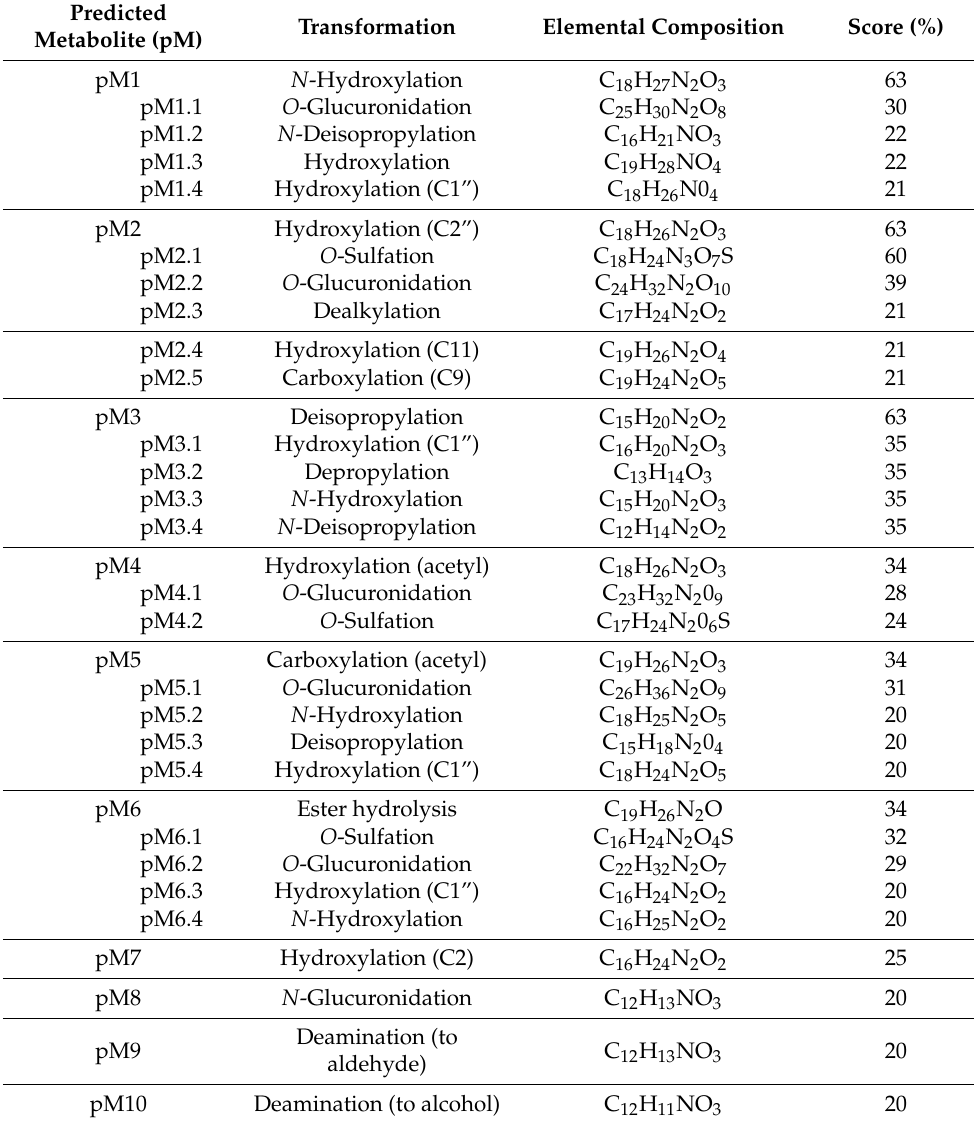
Table 1. Molecular structure, elemental composition, metabolic transformation, and predictive score of in silico-predicted 4-AcO-DiPT